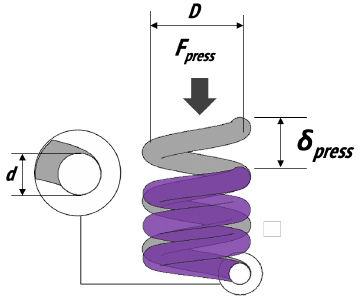
Figure 2. Mechanical structure of a coil